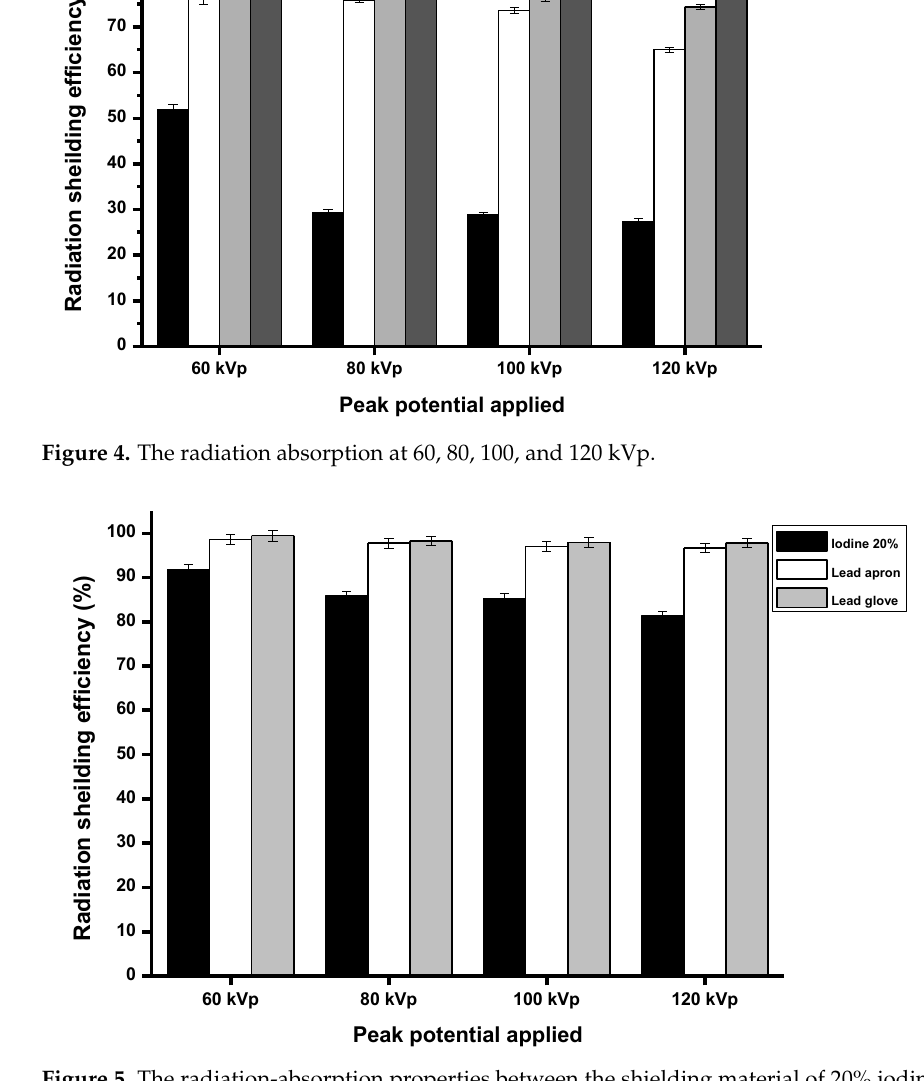
Figure 5. The radiation-absorption properties between the shielding material of 20% iodine contrast media concentration with lead apron and lead glove.